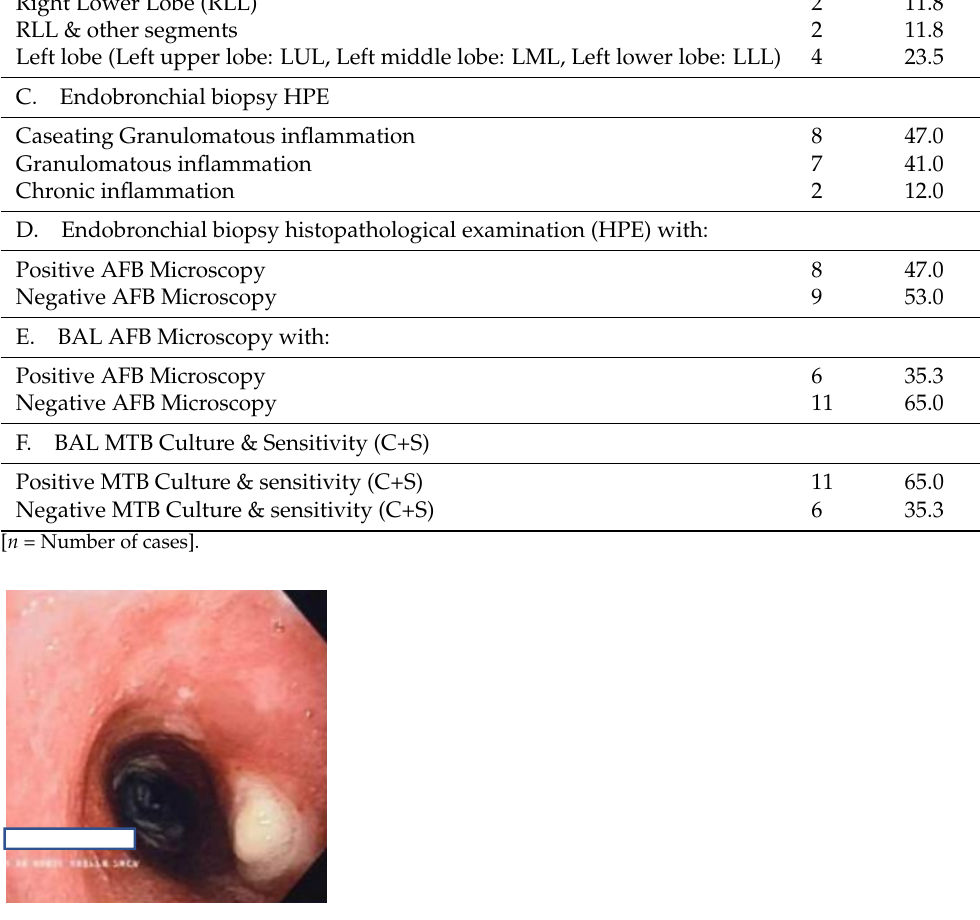
Figure 2. Oedematous hyperaemic lesion. Type 2 Endobronchial TB. RUL (3 cases, 17.7%), RML (2 cases, 11.8%), and RLL (2 cases, 11.8%) were the most common bronchoscopy lesion localizations (2 cases, 11.8%). In four cases, the left lobe was involved (23.5%). Our patients’ CXR localizations and bronchoscopic findings showed no disagreement. (Supplementary S2). Caseating granulomatous inflammation was the most prevalent histopathological examination (HPE) of biopsy specimens, seen in 8 cases (47%), followed by granulomatous inflammation in 7 cases (41%), and chronic inflammation in 2 cases (12 percent). BAL for AFB microscopy was positive in 35% (6 cases), whereas BAL for Mycobacterium cultures was positive in 41% (7 cases) of the patients (Table 2). Table 2. Bronchoscopic features and subtypes of EBTB. Bronchoscopic Features